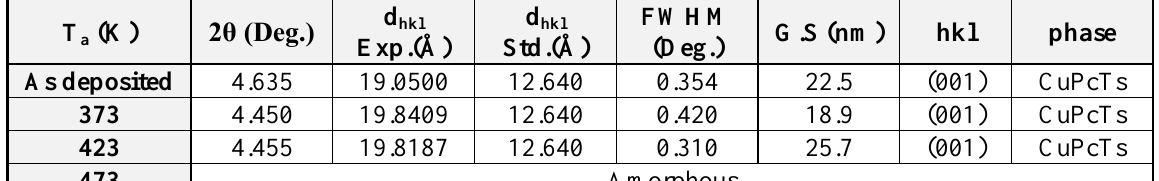
Table 1: Structural parameters for CuPcTs/PEDOT:PSS thin films deposited on glass substrate annealed at different temperature. T a